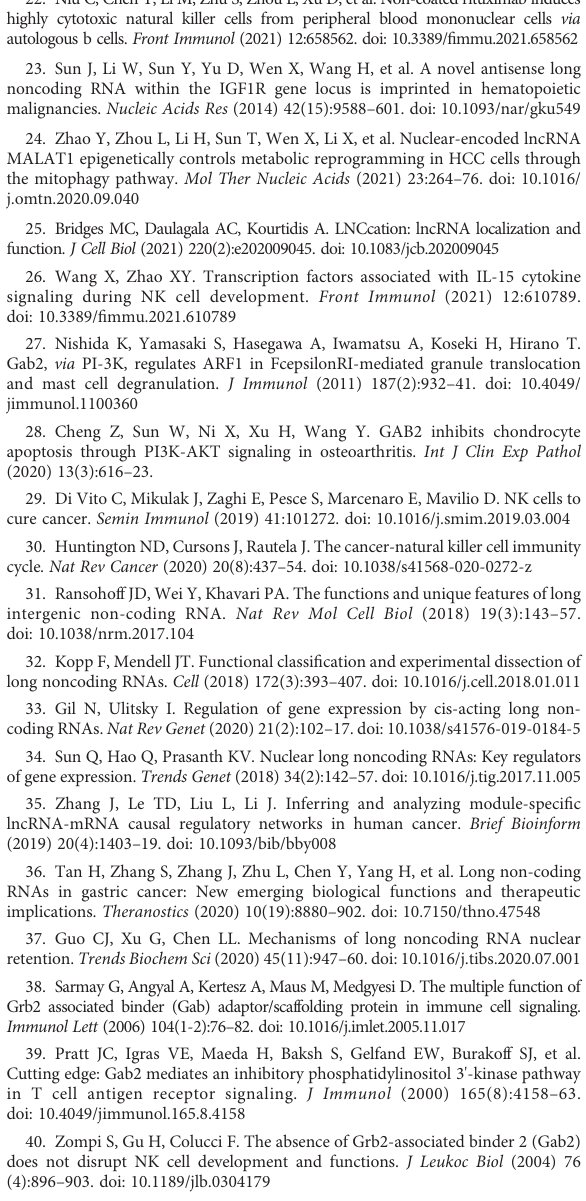
After GFP-positive cell selection, stable cells were collected for qPCR to quantify candidate genes regulated by NCAL1. SUPPLEMENTARY FIGURE 4 Schematic diagram of RNA reverse transcription-associated trap (RAT) qPCR assay. NCAL1 was in situ reverse-transcribed using three NCAL1- speci fi c complementary primers containing biotin-dCTP. Random primers were used as negative controls (RAT-CT). After nuclear lysis, the biotin- NCAL1 cDNA chromatin complexes were isolated using streptavidin beads.